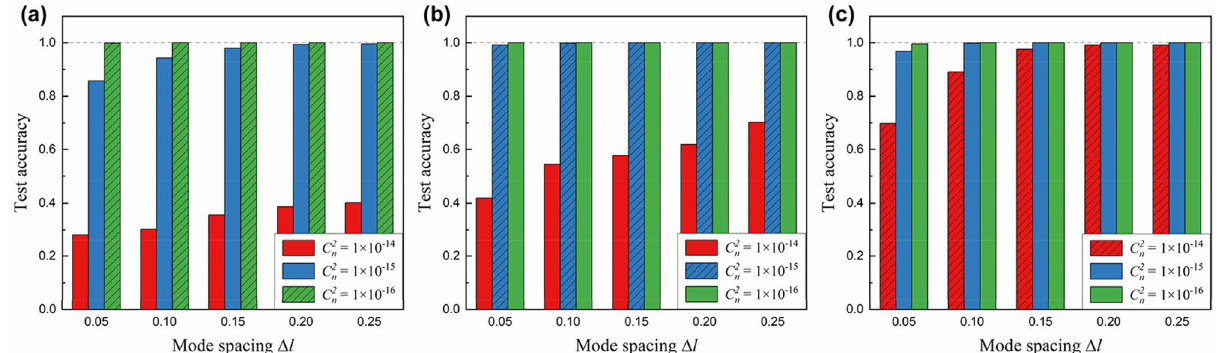
Figure 7. Generalization ability under unknown turbulence environments. Recognition performance 2 1 × 10 − 16 m − 2 / 3 , ( b ) C 2 1 × 10 − 15 m − 2 / 3 , and ( c ) for models trained with a data set of ( a ) C n = n = 1 × 10 − 14 m − 2 / 3 . Hatched bars in each bar graph represent prediction results obtained from test sets with C 2 n = 2 the same AT strength C n as the training sets. Each data shows the mean value of 5 test